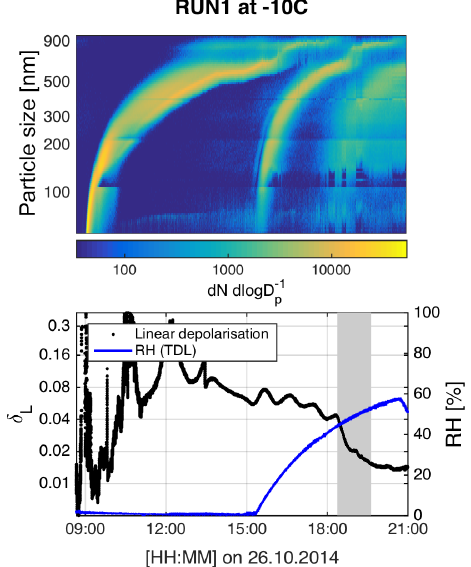
Figure 9. An example of a run with two growing SOA parti- cle modes. The primary mode nucleated around 09:00UTC and reached a median size of 600nm around 15:00UTC, when a sec- ond nucleation burst occurred. The new narrow mode produced the oscillations seen in the depolarization ratio after 15:00UTC. The main mode was too wide and did not cause oscillations. These par- ticles exhibited a phase transition starting around 18:25UTC. The noise in the depolarization signal at the start of the experiment is caused by low signal in the backward